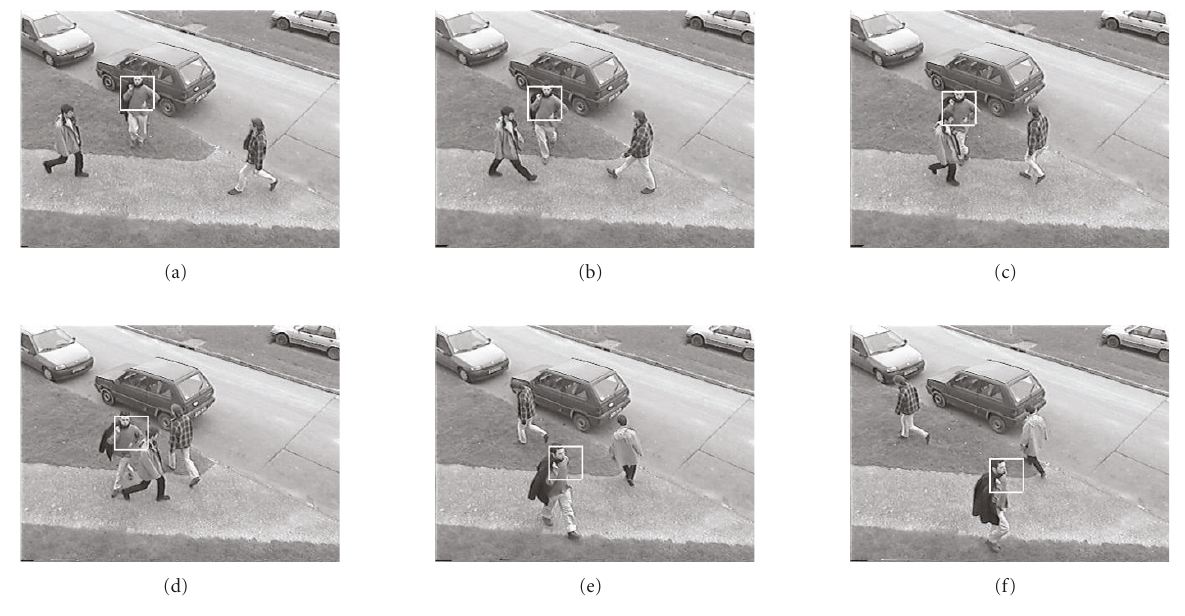
Figure 12: Tracking man 2 in video sequence given in Figure 6 at time t =